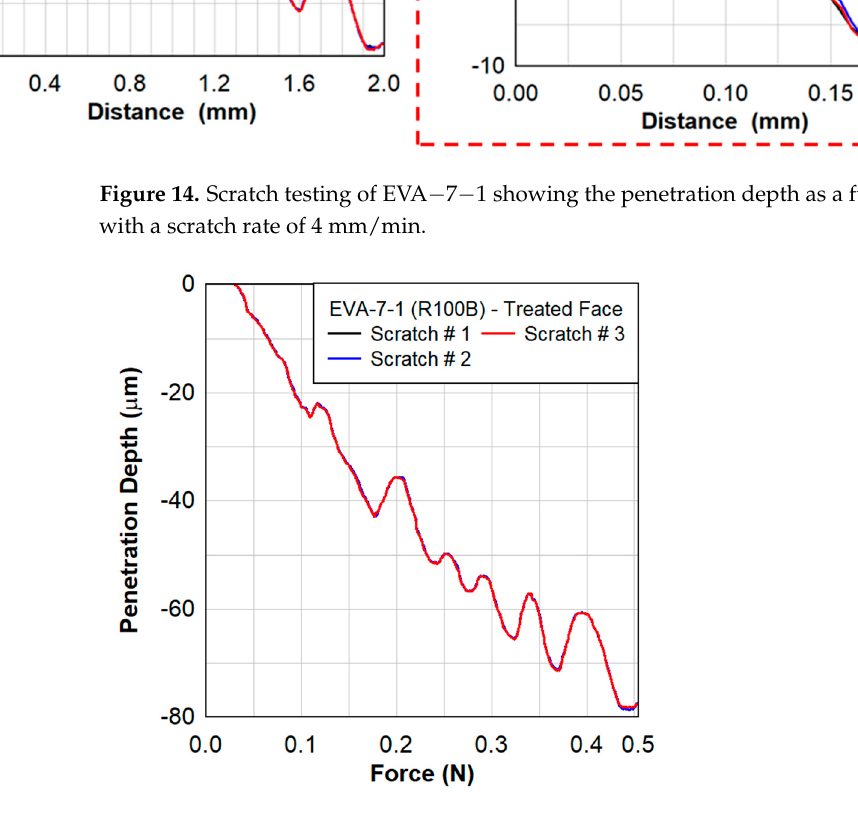
Figure 15. Scratch testing on EVA − 07 − 1 showing the penetration depth as a function of the force applied with a scratch rate of 4 mm/min.